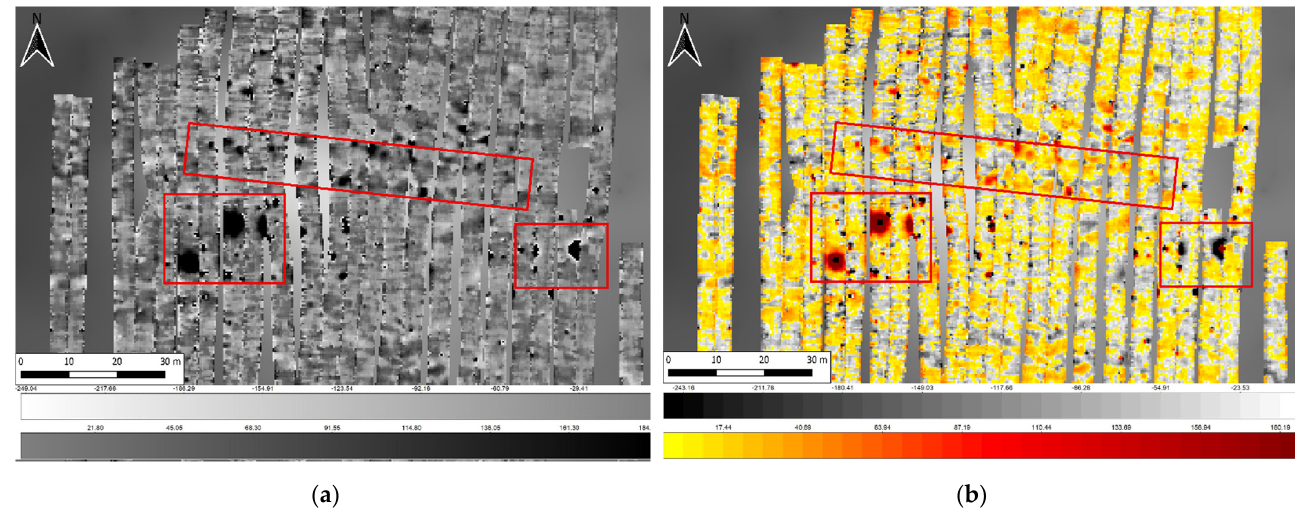
Figure 13. Details of the central zone of the reservoir, where the circular anomalies can be visualized. ( a ) Anomalies in grey scale; ( b ) Anomalies with red and black scale.